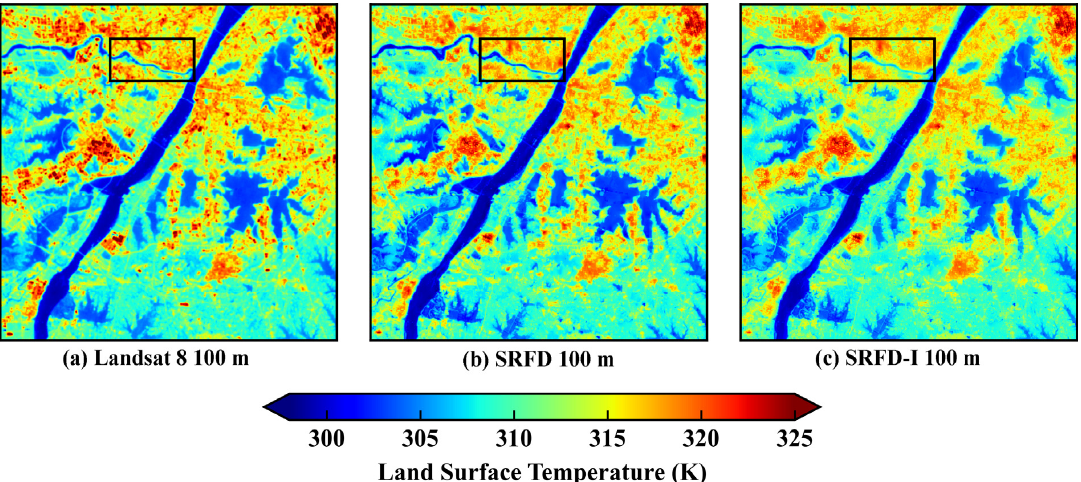
Figure 11. Visual comparison of the downscaled images in W1 with different ways to obtain the fine-resolution spatial feature image. ( a ) Landsat 8 LST (100-m). ( b ) SRFD downscaled LST (100-m). ( c ) SRFD-I downscaled (100-m).